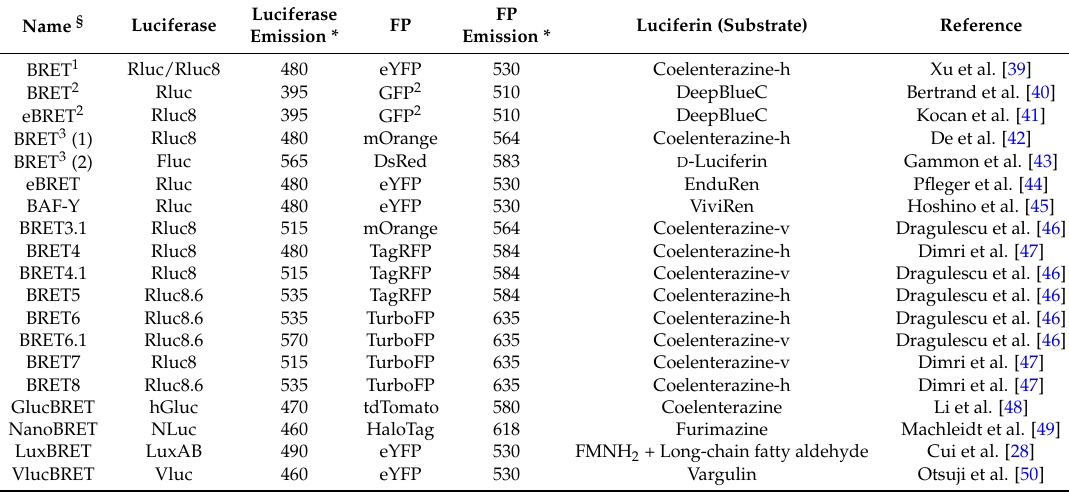
Table 2. Summary of different BRET systems that can be used in PPI studies (Adapted and extended from Borroto-Escuela et al.